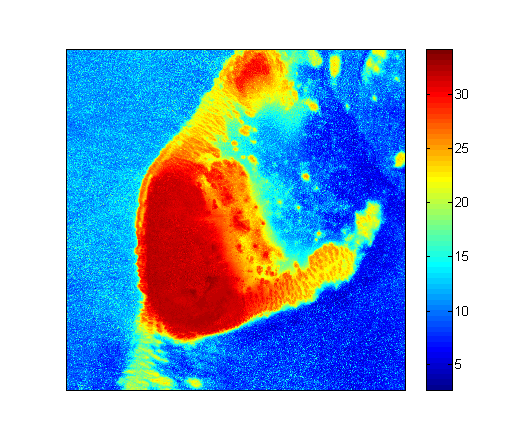
Figure 3. WorldView-2 image around Jing-Hong Island with ground truth position